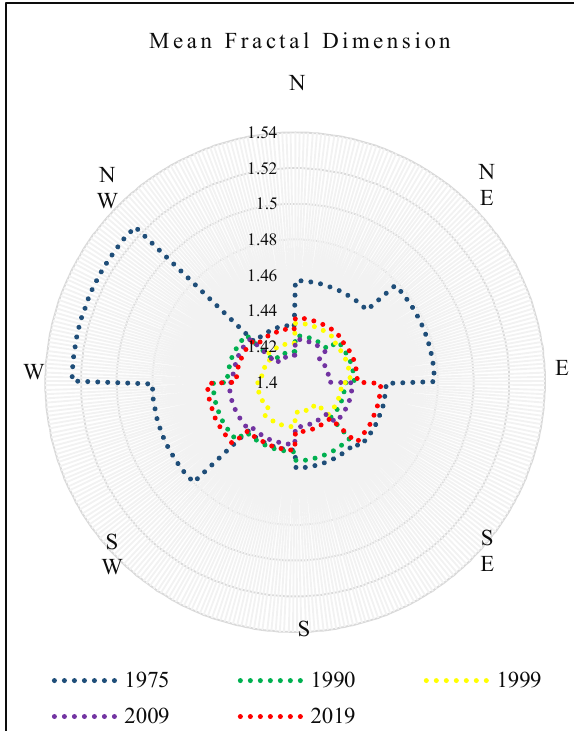
Figure 5. Directional Mean Fractal Dimension